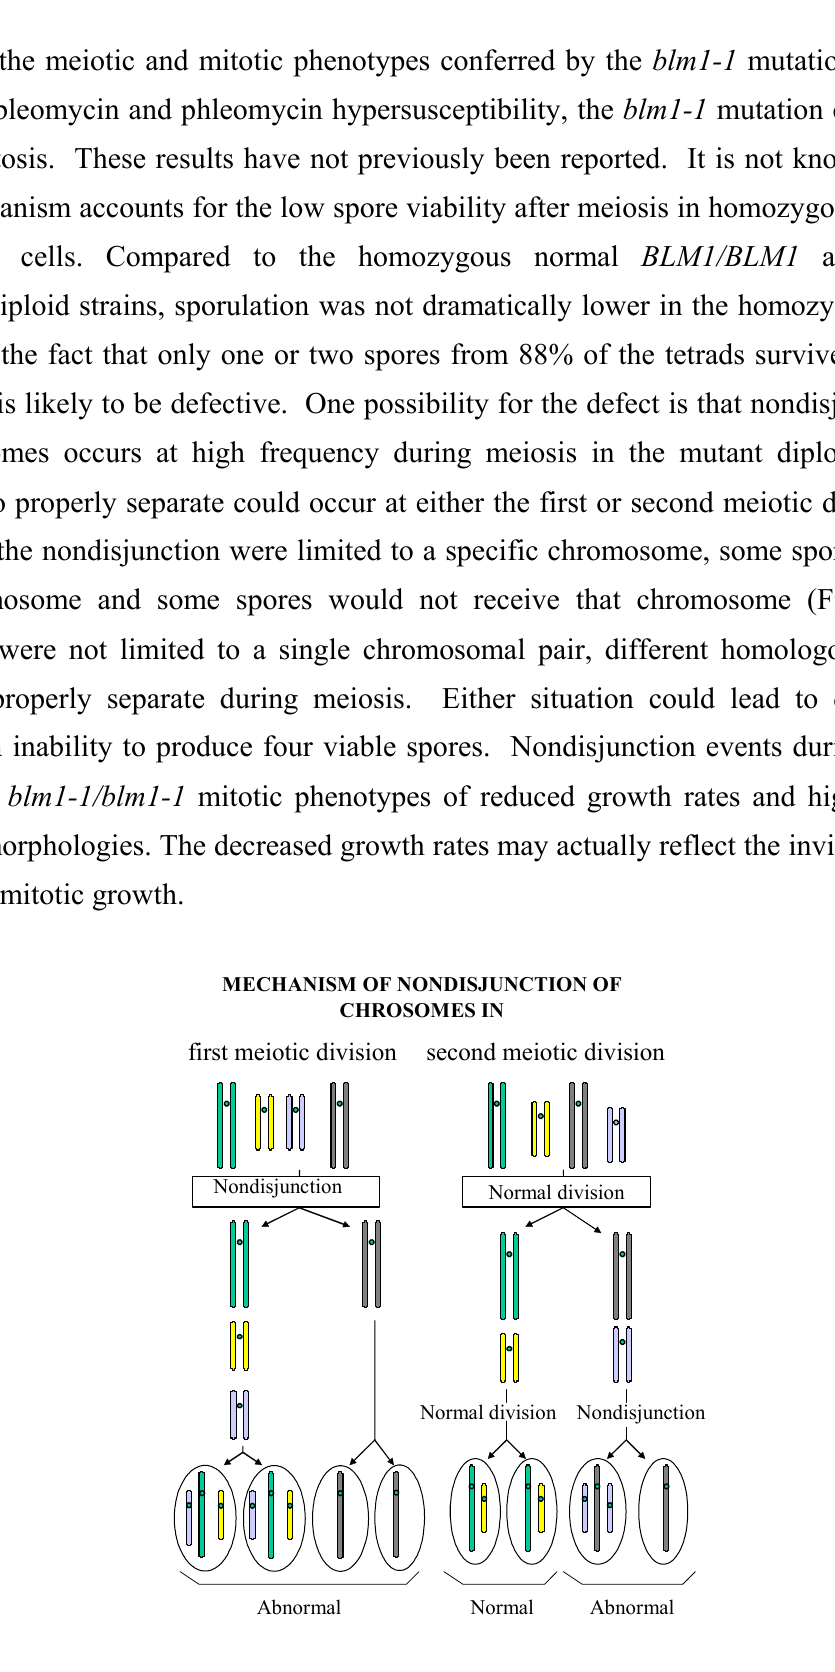
Figure 5. An illustration of the fates of two chromosomal pairs during meiosis. One pair of homologous chromosome behaves normally as it goes through meiosis I and meiosis II. The other pair does not disjoin in either the first or the second meiotic